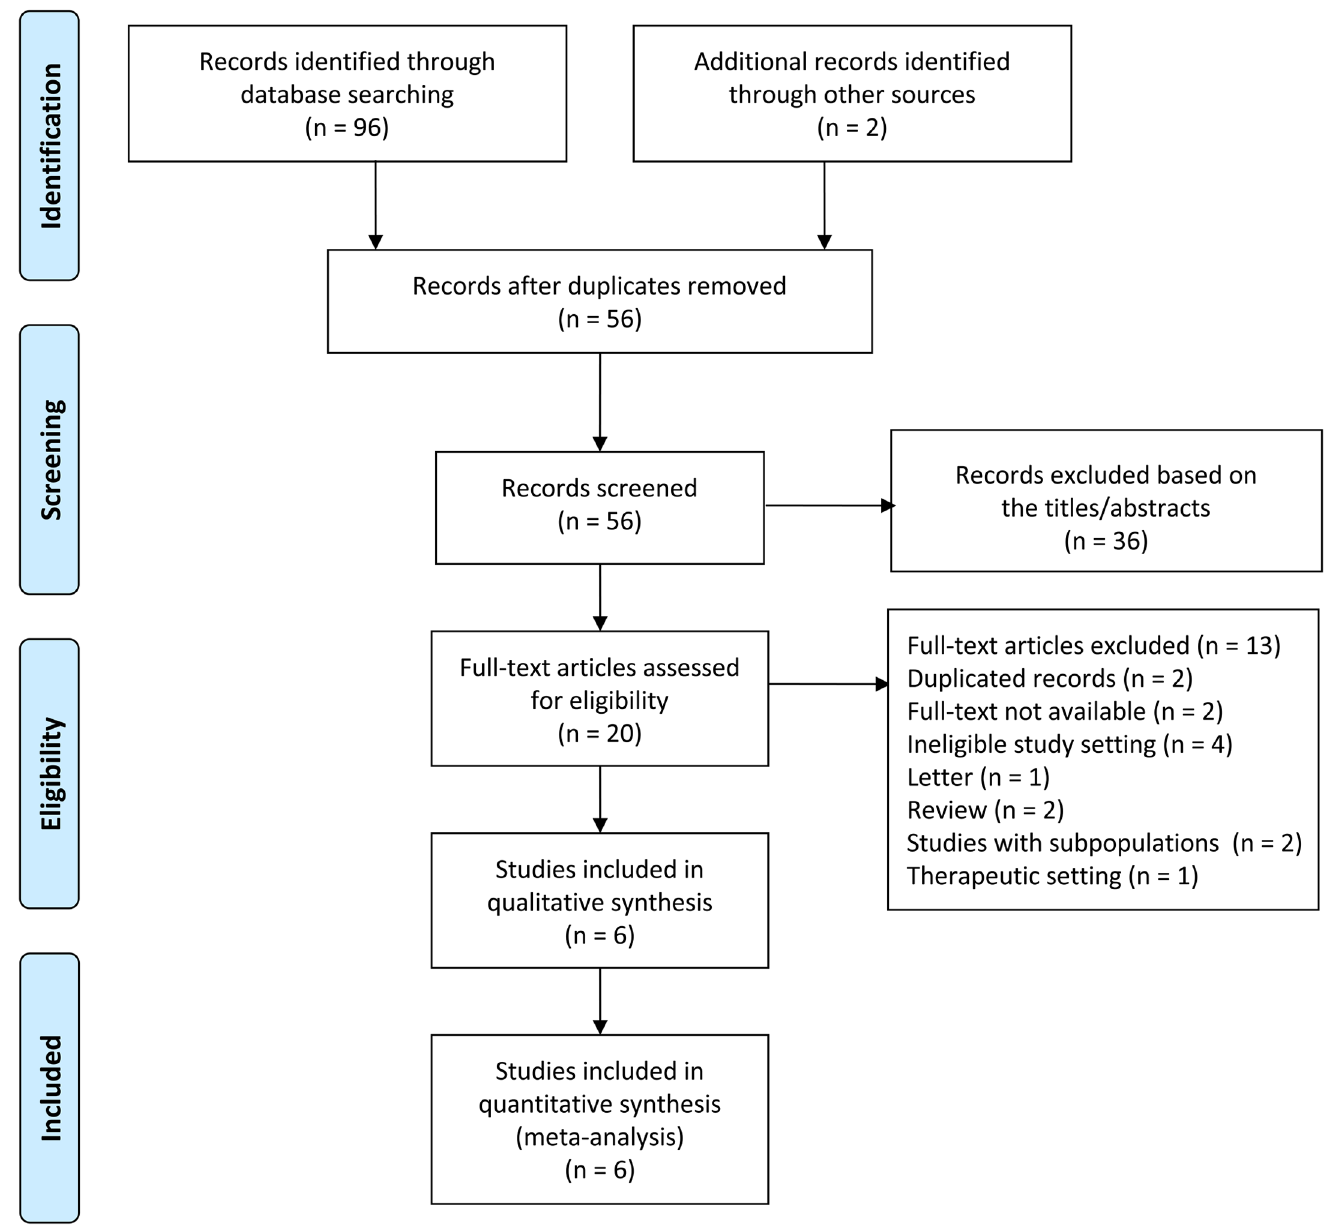
Fig 1. PRISMA flow diagram of the search result of the meta-analysis.